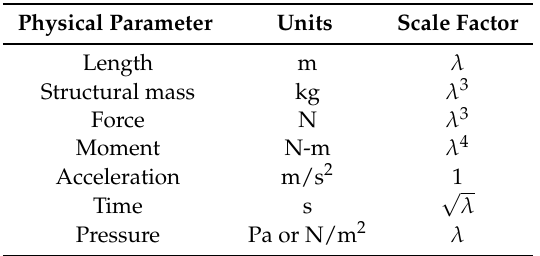
Table 5. Froude scaling used in the model